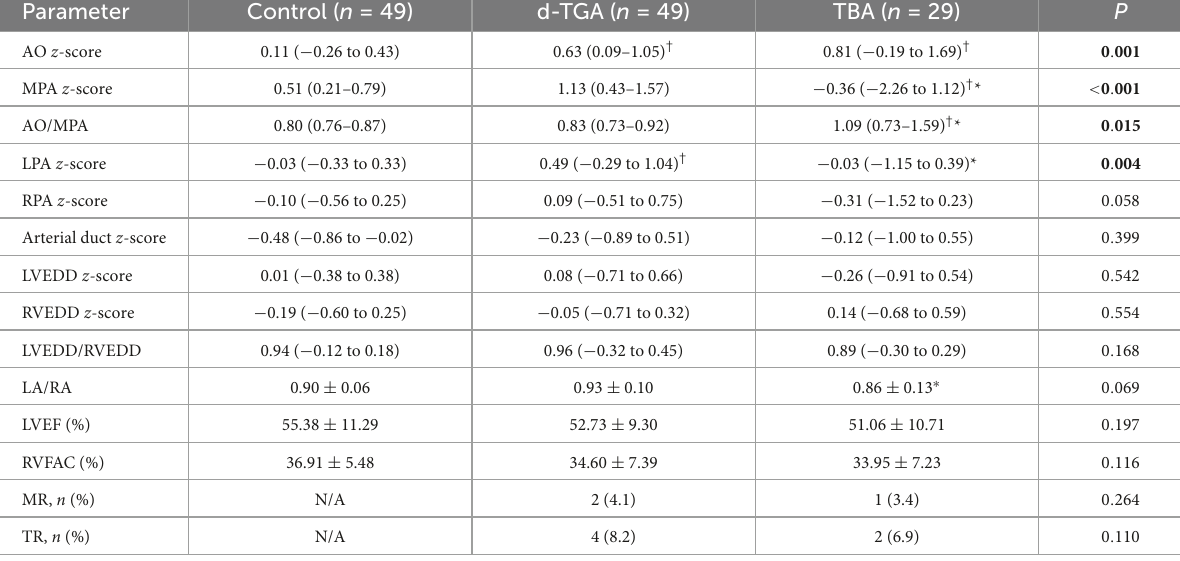
TABLE 2 Echocardiographic features of the fetal study population.